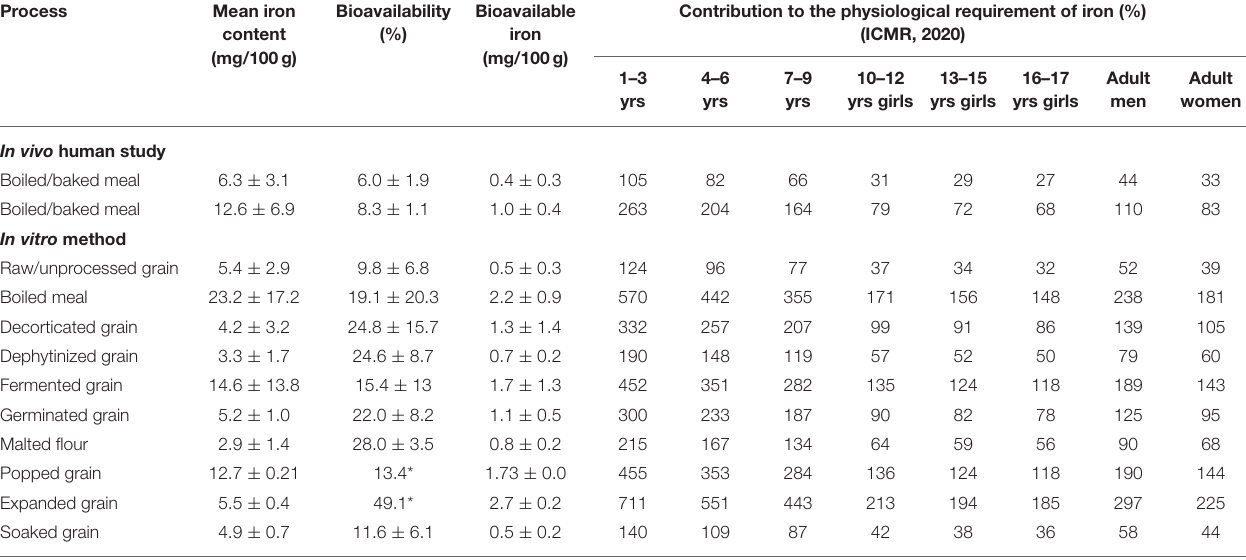
TABLE 3 | The effect of processing on the bioavailability of iron in millets and its potential to meet the physiological requirement of iron.